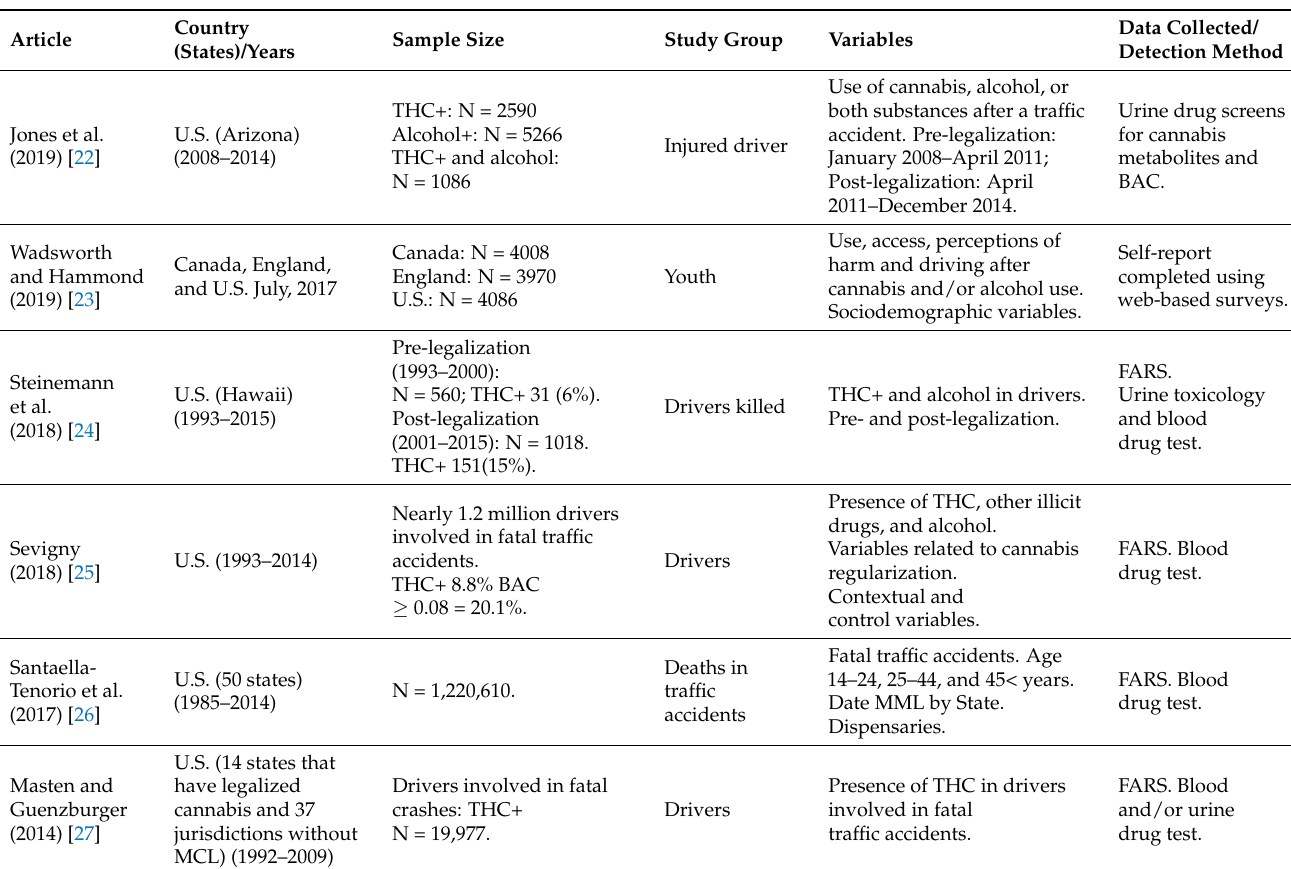
Table 1. Studies related to the legalization of medical cannabis: country, sample, and most rele- vant